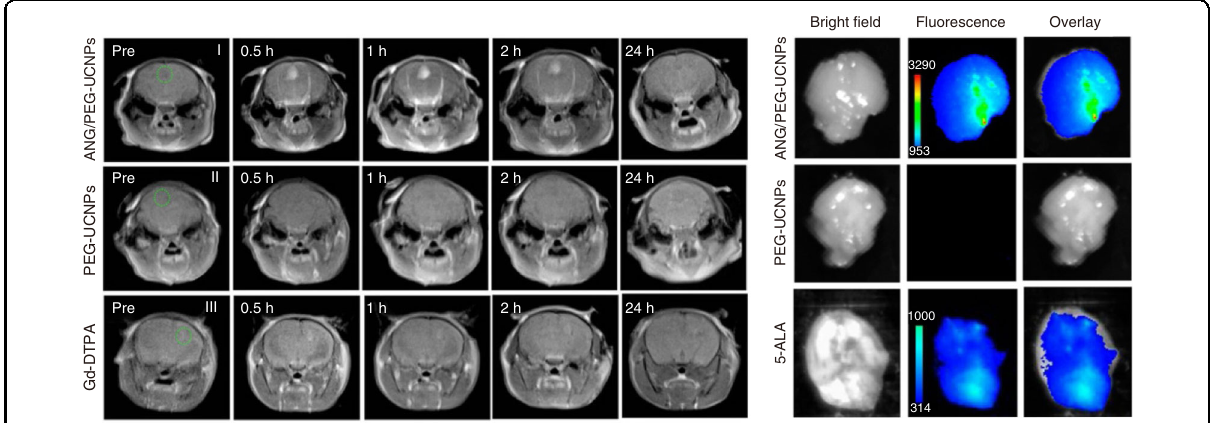
Fig. 5 Intravital dual-modal MRI/UCL imaging of brain tumor after injection of ANG/PEG-UCNPs, PEG-UCNPs and Gd-DTPA. Reprinted with permission from ref. 76 . Copyright 2014 American Chemical